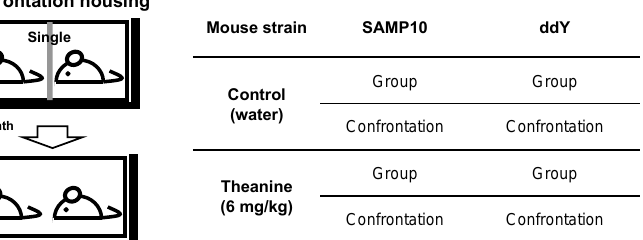
Table 1. Data of principal component analysis of metabolites in senescence-accelerated mouse prone 10 (SAMP10) and ddY mice.